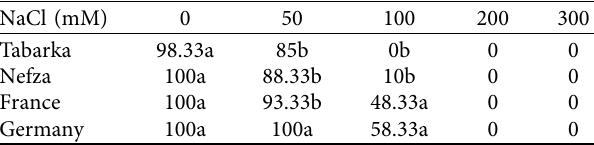
Means in each column followed by the same letters are not significantly different ( P > 0 . 05). Table 2: Effect of PEG on the germination rate of M.officinalis seeds.